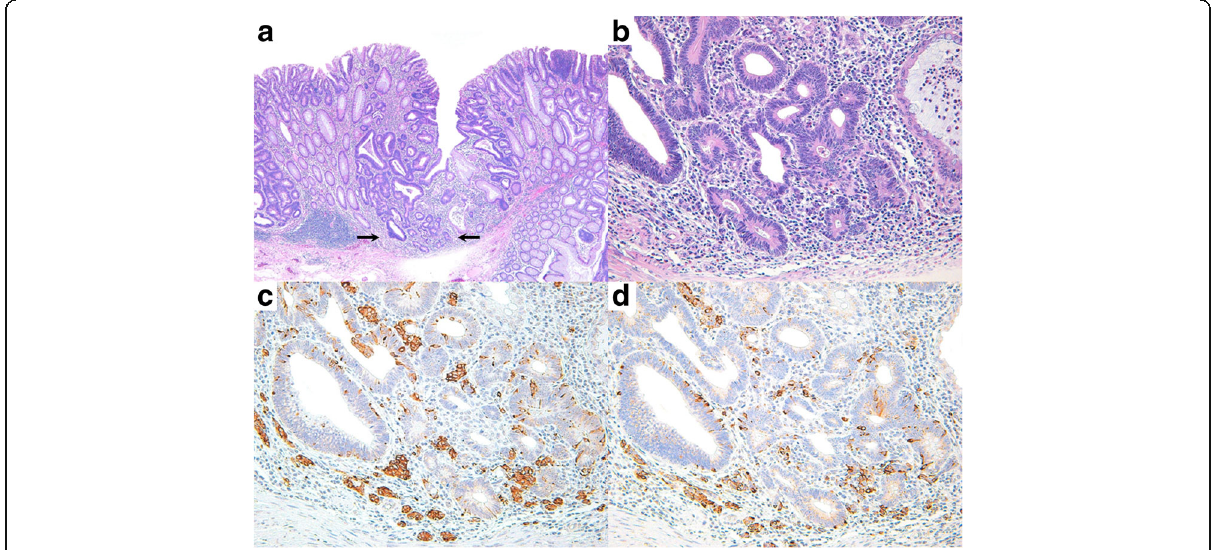
Fig. 1 Histological and immunohistochemical findings of composite intestinal adenoma-microcarcinoid. a Low power magnification shows adenomatous polyp with hardly recognizable microcarcinoid component (×40). Black arrows indicate microcarcinoid component. b High power magnification displays adenomatous glands and neuroendocrine cell nests in the lamina propria, which are connected to each other (×200). c Immunohistochemical staining for synaptophysin shows diffuse cytoplasmic reactivity in the microcarcinoid component (×200). d The microcarcinoid component is diffusely stained for chromogranin-A on immunostaining